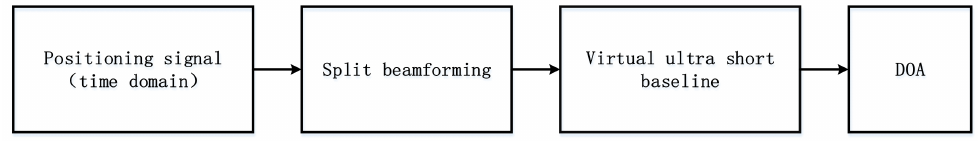
Figure 9. Ultra-short baseline